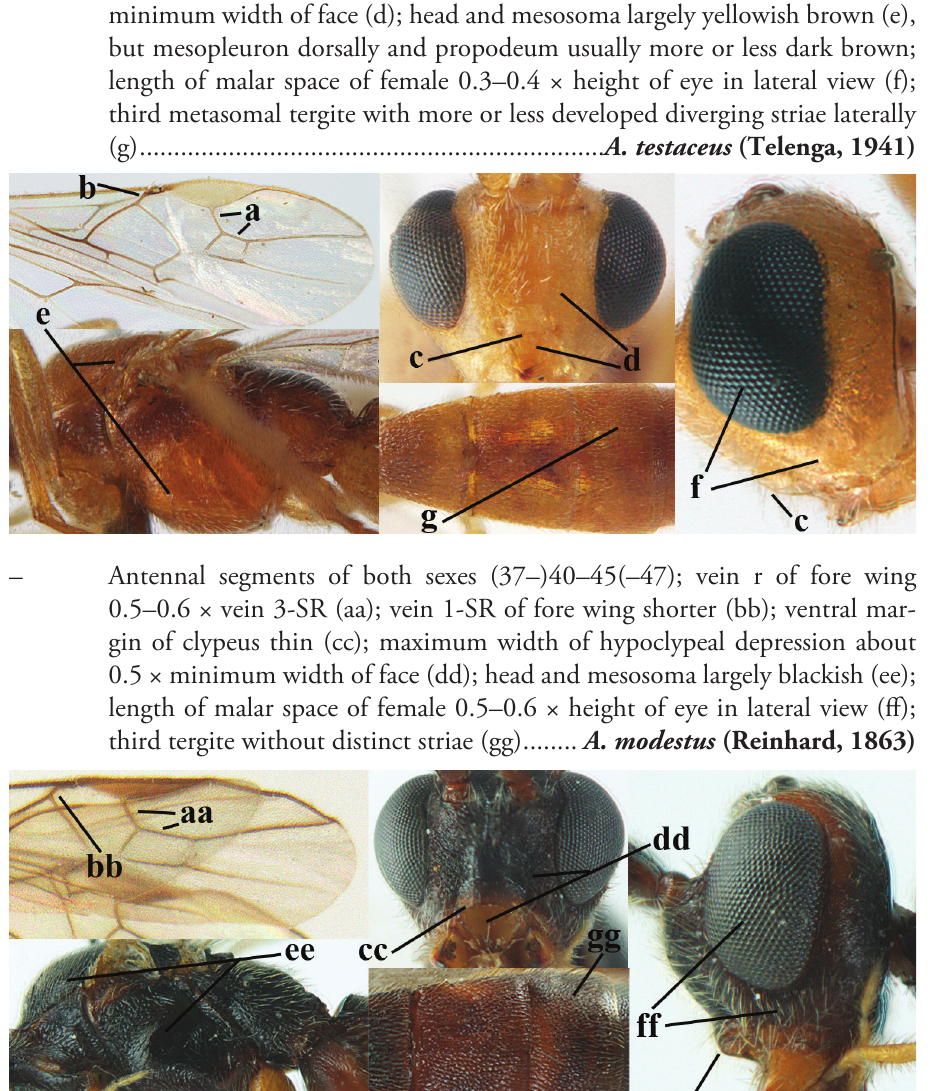
Antennal segments of female 30–35 (of male 34–37); vein r of fore wing 0.7– 0.9 × vein 3-SR (a); vein 1-SR of fore wing rather long (b); ventral margin of clypeus thick (c); maximum width of hypoclypeal depression 0.30–0.35 × minimum width of face (d); head and mesosoma largely yellowish brown (e), but mesopleuron dorsally and propodeum usually more or less dark brown; length of malar space of female 0.3–0.4 × height of eye in lateral view (f); third metasomal tergite with more or less developed diverging striae laterally (g) .................................................................... A. testaceus (Telenga, 1941)